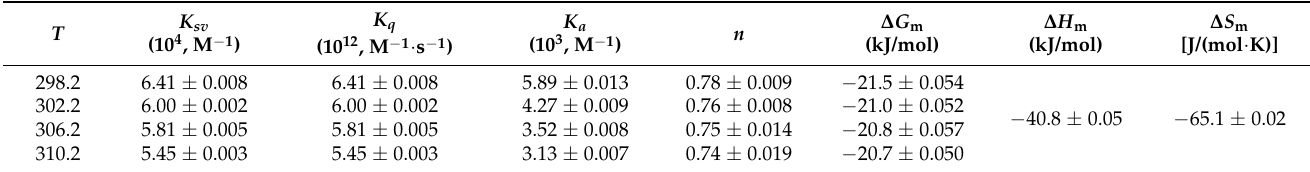
Table 1. Quenching constants, binding constants and thermodynamic parameters of the interaction between CAPE and Hb in pH 7.4 phosphate buffer solution at different temperatures.